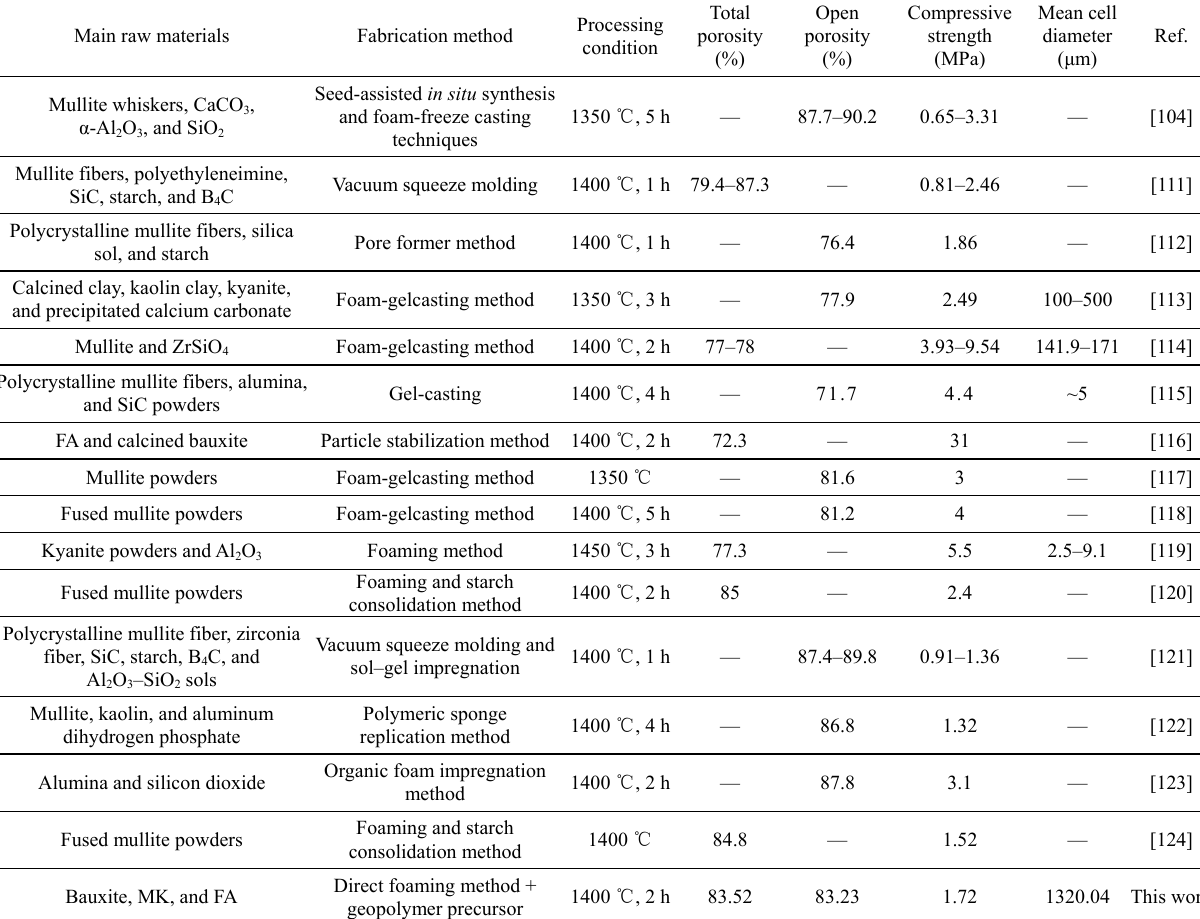
Table 3 Raw materials, fabrication methods and processing conditions, total porosity, open porosity, compressive strength, and mean cell diameters of porous mullite ceramics produced using different raw materials and processing